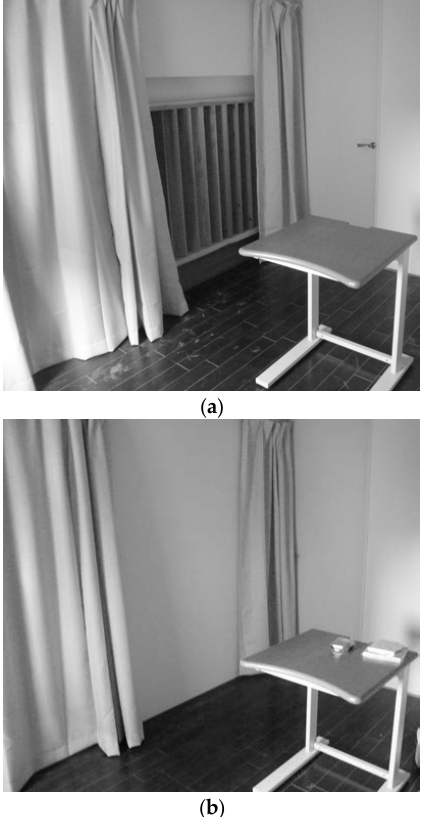
Figure 1. Overview of experimental rooms. To avoid a potential visual effect of cedar timber, a curtain was closed to create a same view for subjects in the two rooms during the experiment. ( a ) Case room; ( b ) Control room. Table 1. Characteristics of participants.